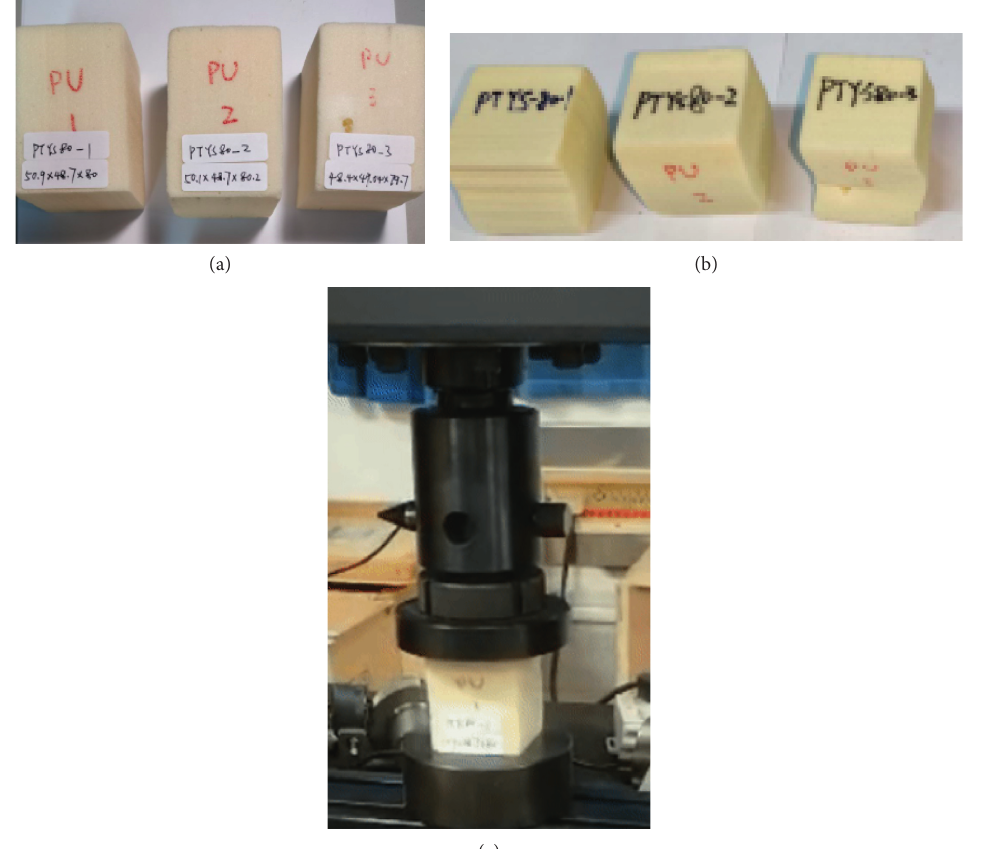
Figure 3: Experiments of polyurethane foam for uniaxial compression: (a) specimens before testing; (b) specimens after testing; (c) experimental